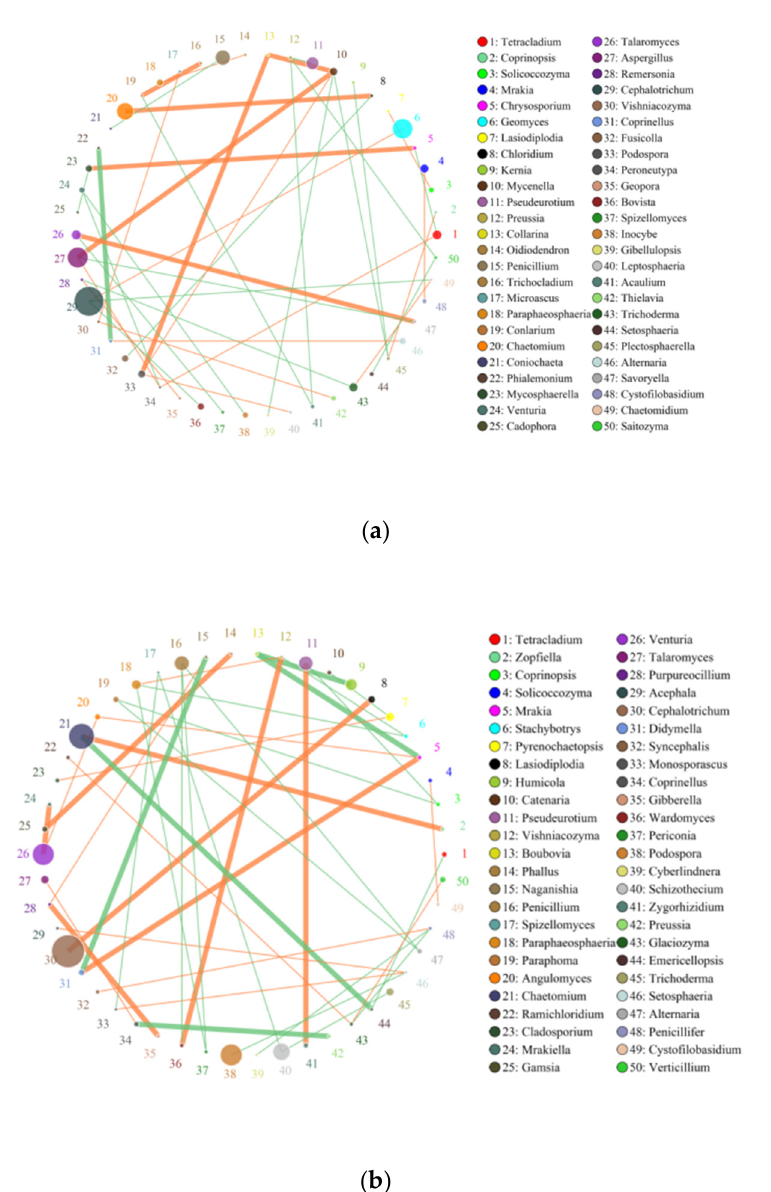
Figure 7. Interaction networks of the main fungal genera in the soil: ( a ) ridge tillage at two fertilizer depths ( L ); ( b ) conventional cultivation ( P ). Orange and green lines represent positive and negative correlations, respectively; line thickness represents correlation coefficient, and line number represents the degree of closeness between nodes.